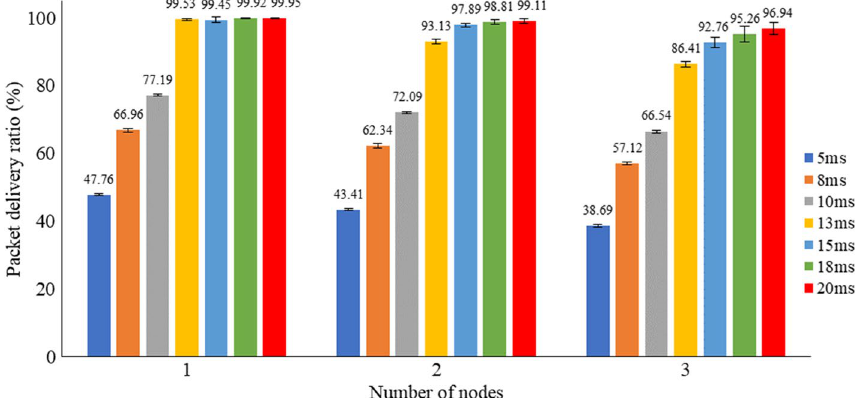
Fig. 11 The PDR for the test case #2; varying number of nodes and the packet inter-arrival